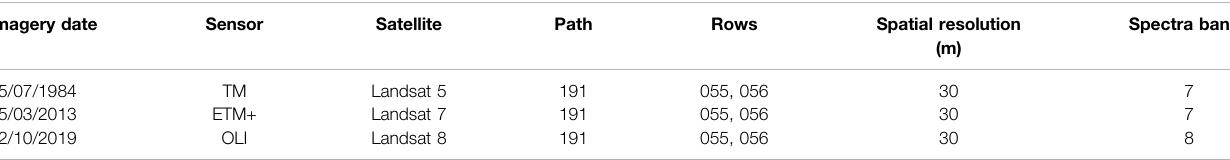
TABLE 1 | Description of Landsat data resources used for analysis in Lagos